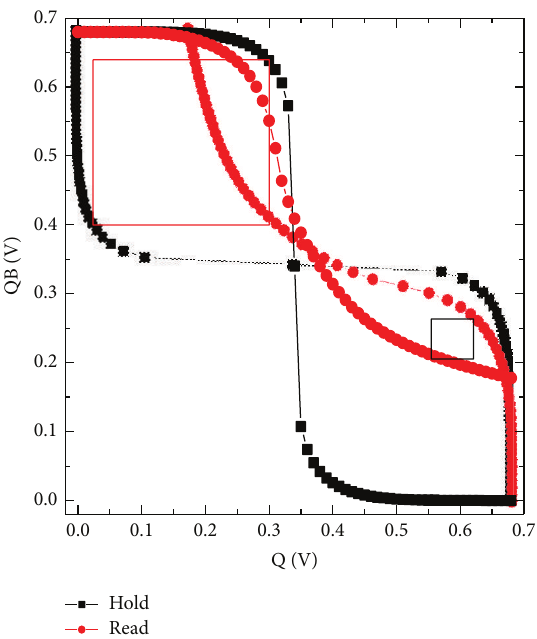
Figure 11: Predicted SRAM hold and read SNM curves.